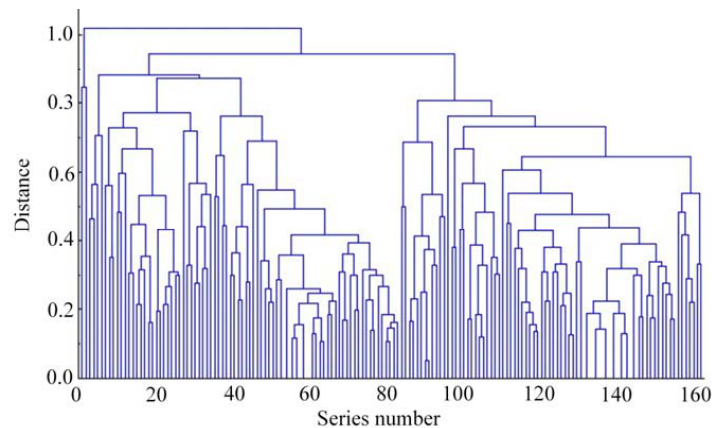
Fig. 2: Clusters of UV-B-responsive trees and of climatic-responsive trees